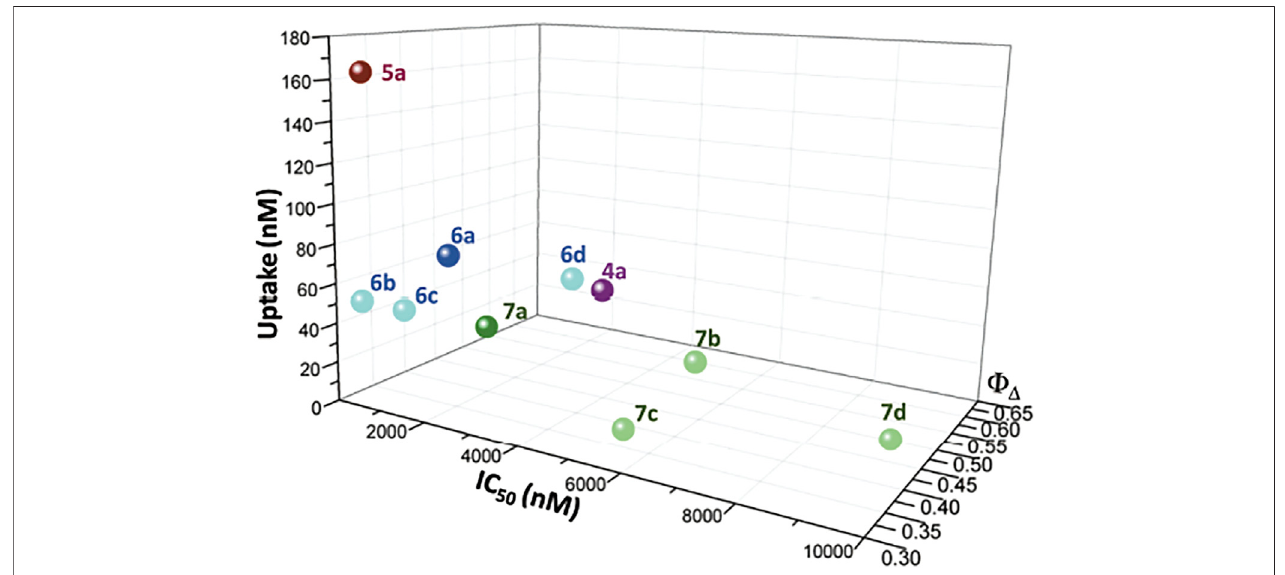
FIGURE 6 | Plot of the singlet oxygen formation quantum yields, cell uptake, and IC 50 values in human A375 skin malignant melanoma cells of chlorins 4a , 5a , 6 , and 7 .